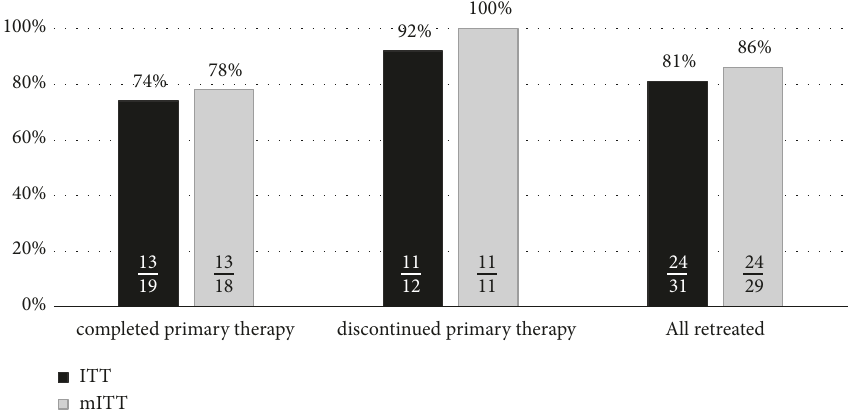
Figure 1: Efficacy of retreatment according to intent-to-treat(ITT) or modified ITT (mITT) analysis in all retreated and based on completed or discontinued primary therapy; mITT analysis was carried out without lost to follow-up patients. Table 2: Efficacy total, by primary regimen including on schedule/discont, by rescue regimen, by GT, and by fibrosis. ITT, n (%) mITT, n (%) completed primary discontinued therapy